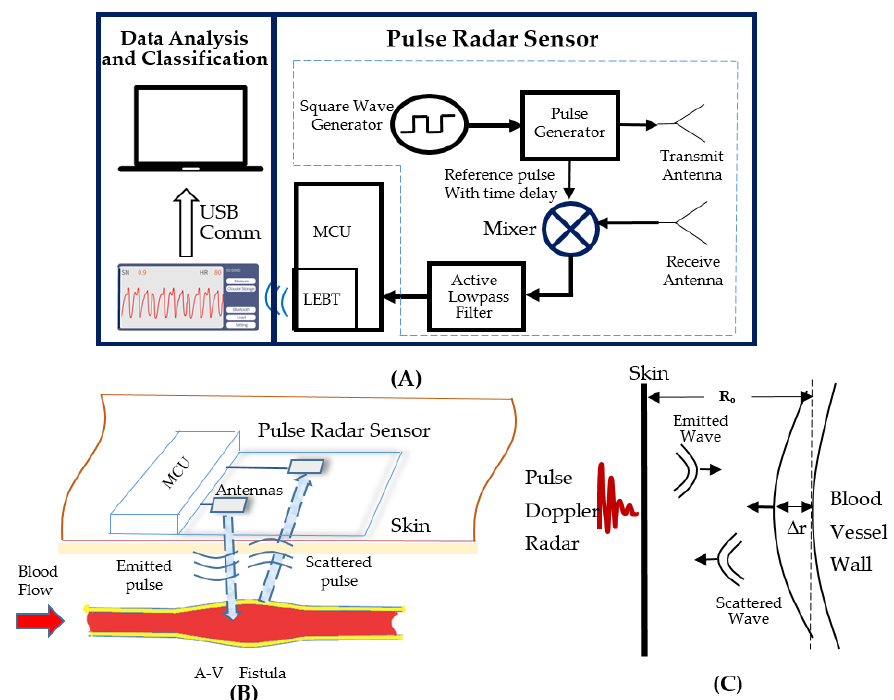
Figure 1. The system diagram of the VWM monitor and the principle of measuring the AVF vessel wall movement ( A ). The diagram of pulse radar sensor detect blood flow ( B ). The diagram of pulse Doppler radar emit and receive the signals of wave ( C ).